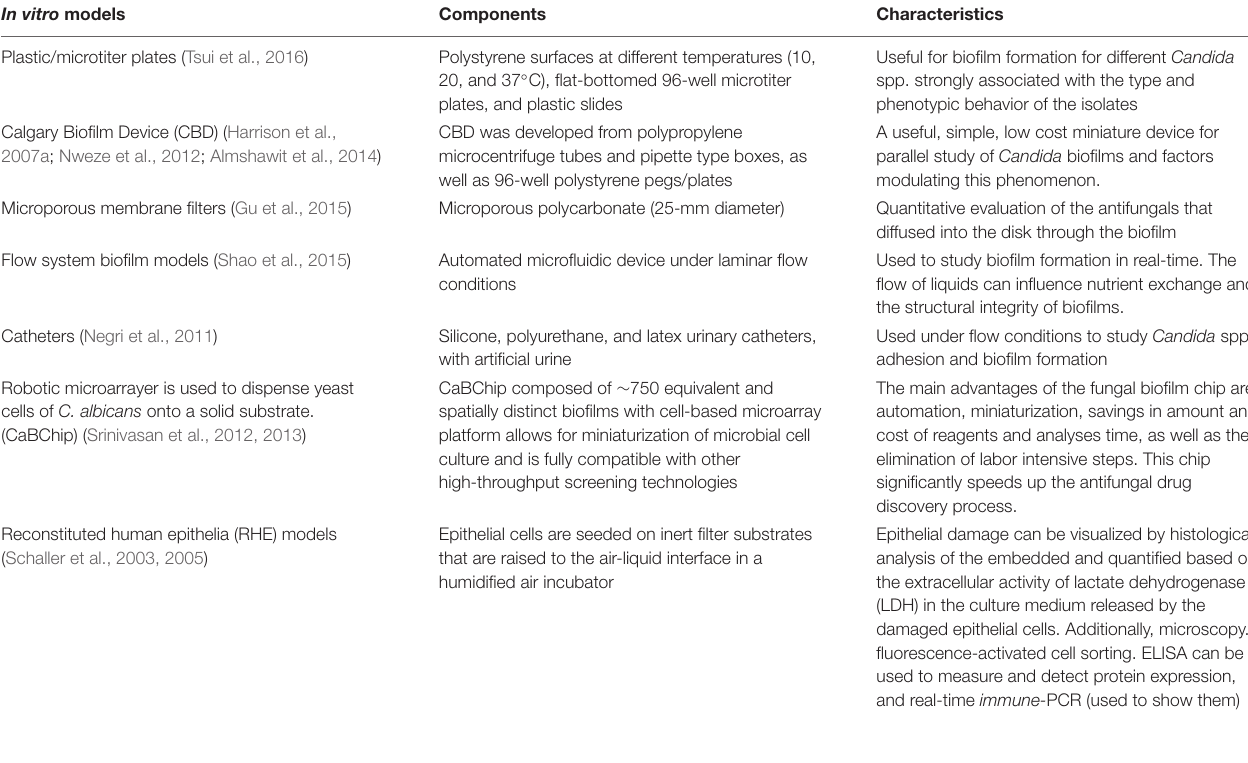
TABLE 3 | Schema for in vitro Candida spp. related to biofilm models. In vitro